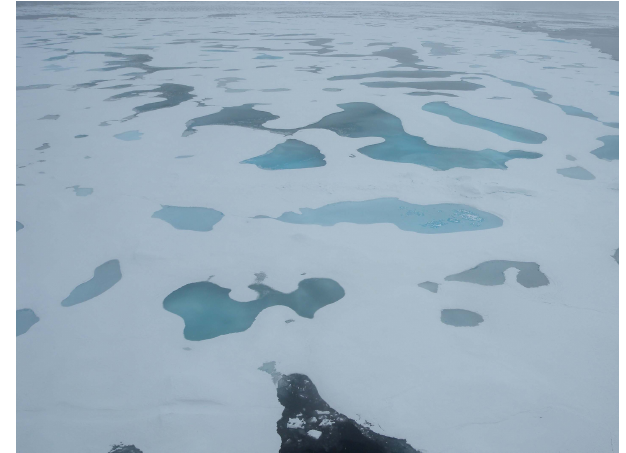
Figure 1. A typical image of melt ponds on Arctic sea ice captured onboard R/V Xuelong during the Chinese National Arctic Research Expeditions in summer 2016, clearly illustrating the large variabil- ity of pond color even on the same ice